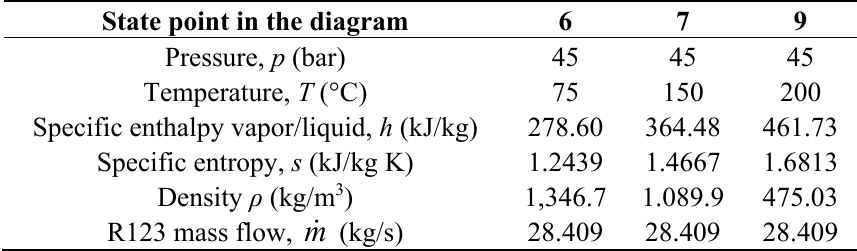
Table 8. R123 state points at heating; repeated calculation.